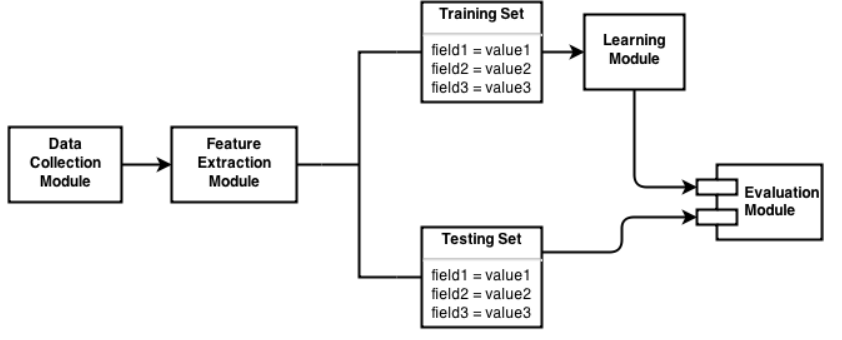
Figure 1. General model of fall detection (FD) and fall prevention (FP) systems.